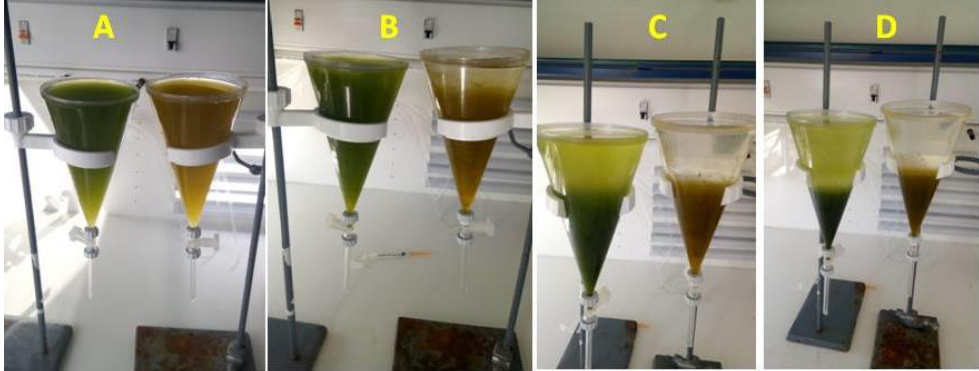
Figure 4. The progress of sedimentation of the filaments of Phormidium sp. of an early (green col- ored) and a late (olive-yellow) culture lasting ~1 h between stage ( A – D